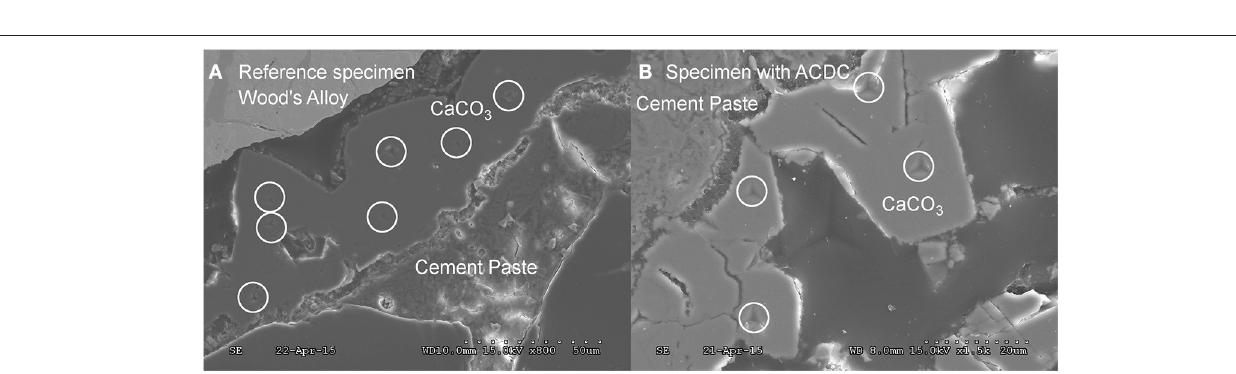
FIGURE 7 | SEM micrographs showing the indentation points whilst mechanical testing of the calcite (A) calcite formed in reference specimen (B) calcite formed in microbial specimen (0.5% ACDC). “ ” indicates the points analyzed during indentation. Please refer to Supplementary Figure 3 for higher ◦ resolution on